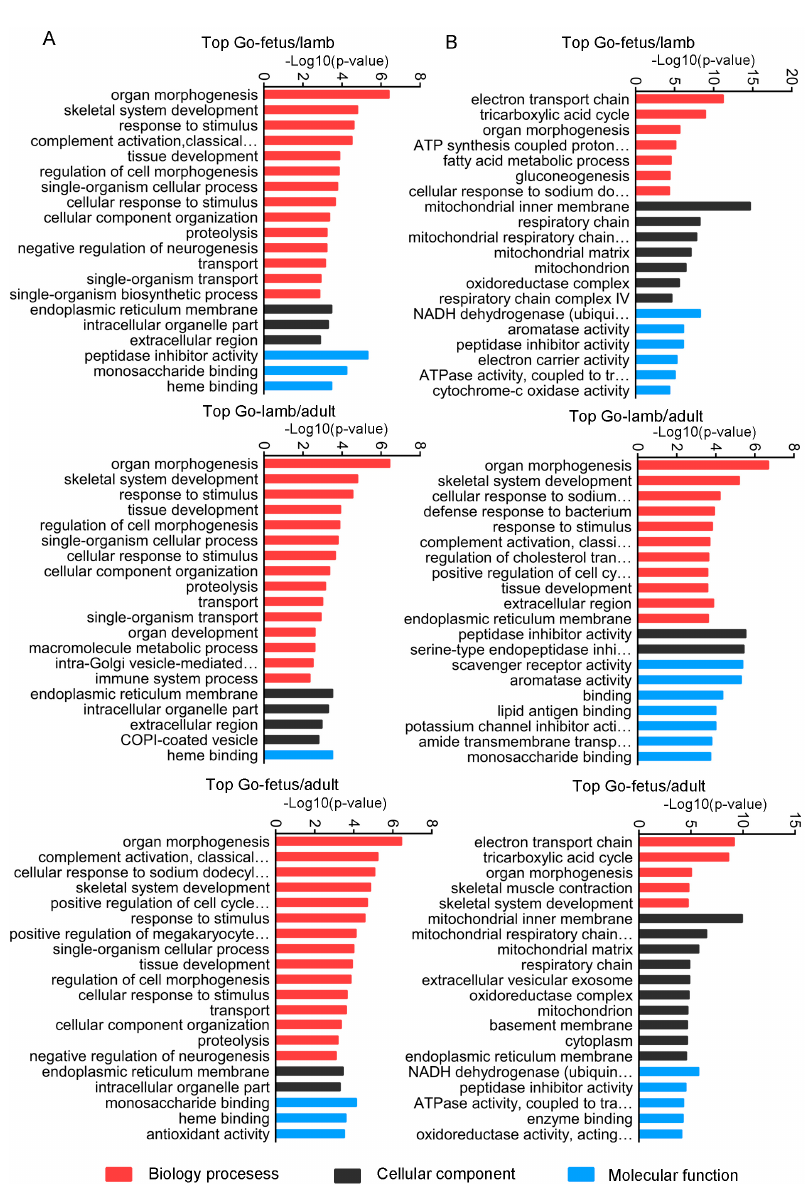
Figure 6. The top GO enrichment analyses of the target genes of the differentially expressed lncRNAs and DEGs in (control/experiment) fetus/lamb, lamb/adult and fetus/adult comparisons. ( A ) The top 20 GO terms enriched by the target genes of the differentially expressed lncRNAs in each comparison. ( B ) The top 20 GO terms enriched by DEGs in each comparison.